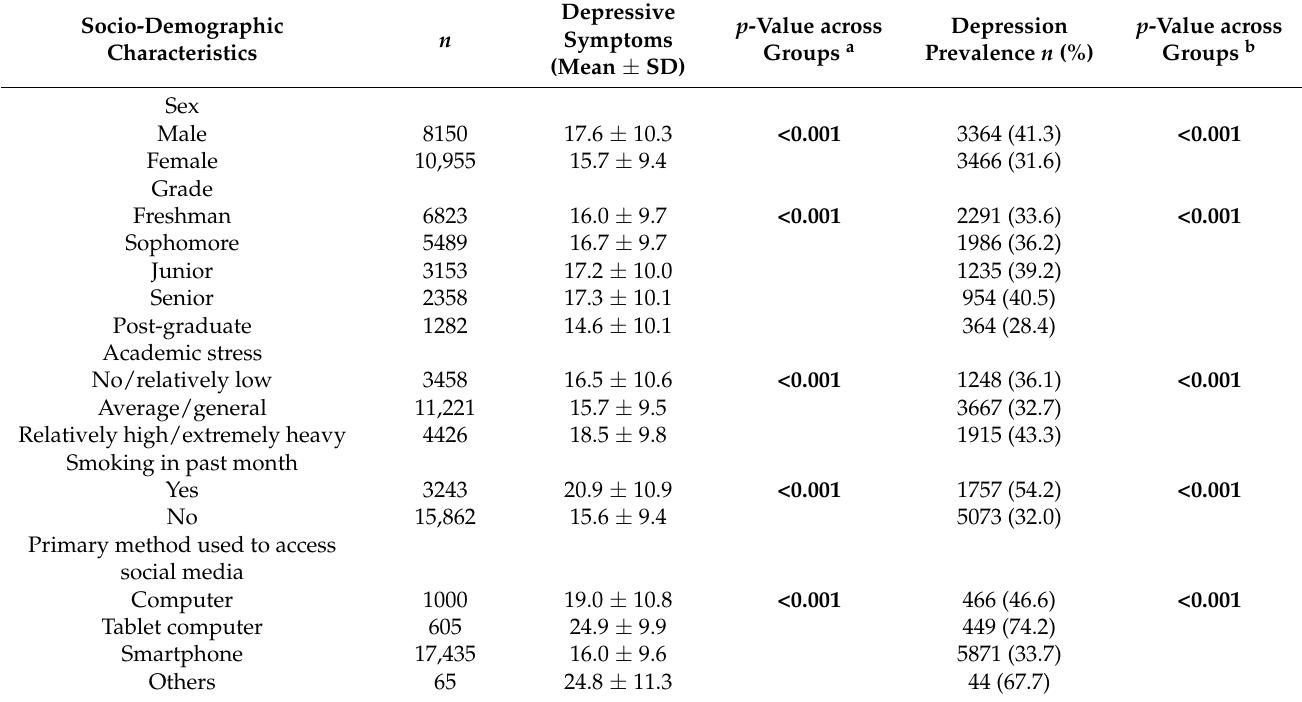
Table 1. Depressive symptoms and prevalence of depression (CESD ≥ 16) among college students in Shaanxi, China by socio-demographic